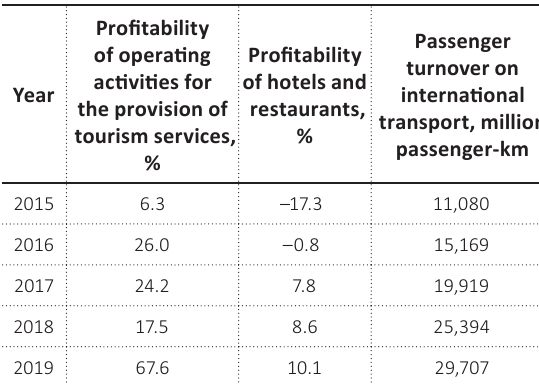
Table 2. Dynamics in the number of tourists who were served by tour operators and agents